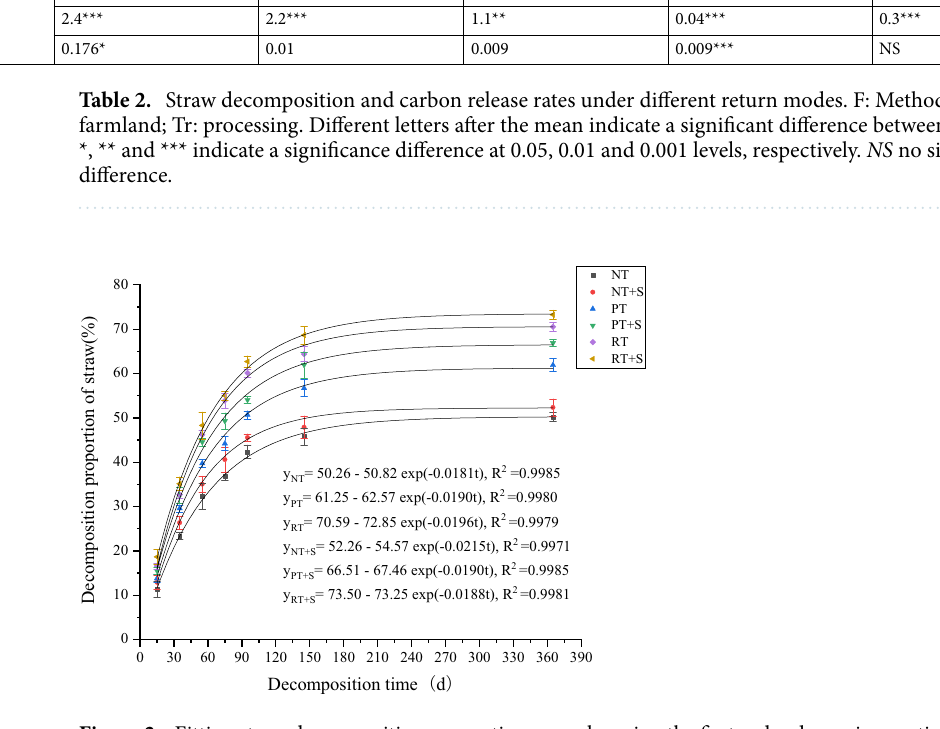
Figure 2. Fitting straw decomposition proportion curve by using the first order dynamic equation. NT no-tillage and straw return to the field + no straw decomposer, NT + S no-tillage and straw return to the field + straw decomposer, PT deep loosening + deep rotary tillage + no straw decomposer, PT + S deep loosening + deep rotary tillage + straw decomposer, RT rotary tillage + no straw decomposer, RT + S rotary tillage + straw decomposer. The same